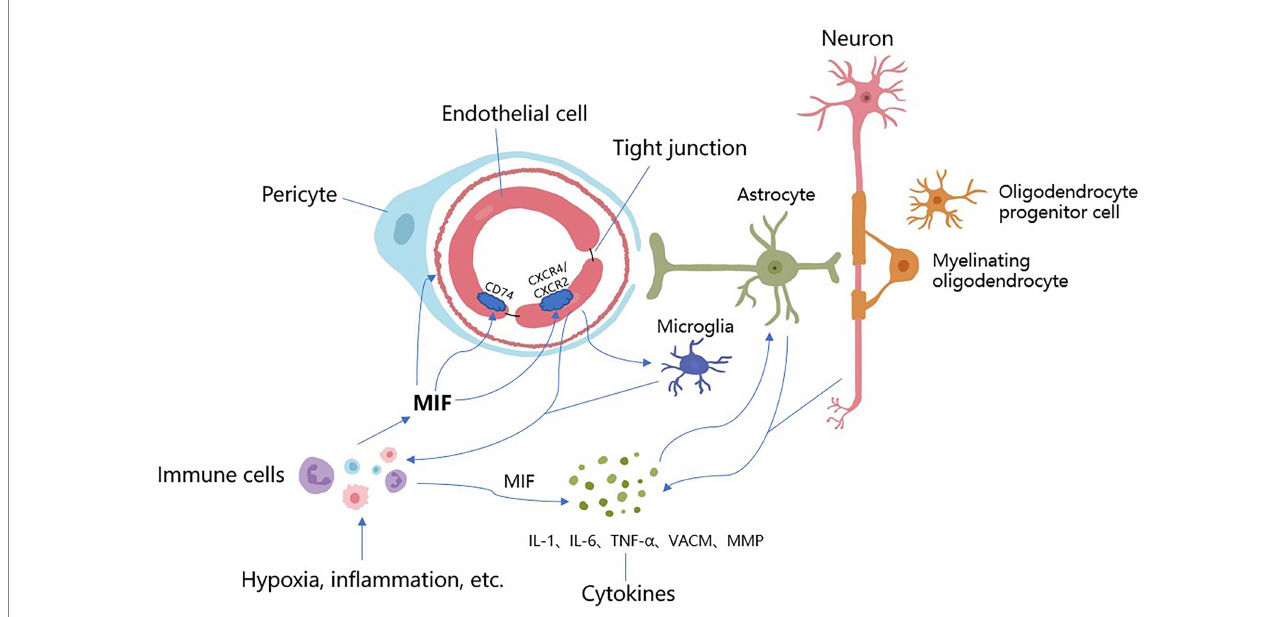
FIGURE 1 The underlying mechanisms of MIF acting on CSVD. Stimulated by hypoxia, inflammation and other factors, MIF is expressed in large quantities from immune cells (i.e., mononuclear, macrophages), which promotes arteriolosclerosis, narrows the lumen and reduces cerebral blood flow, resulting in further hypoxia and ischemia of the brain parenchyma. After binding to receptors, MIF causes endothelial autophagy, promotes endothelial cell dysfunction and BBB destruction, increases vascular permeability, allows harmful components and immune cells to enter the brain parenchyma, and causes neuroinflammation and direct neurotoxic effects. Meanwhile, MIF activates immune cells and microglia, promotes the expression of MIF, activates a series of cytokines (IL-1, IL-6, TNF- α , VCAM, MMP, etc.), accelerates inflammatory response, induces vascular damage, and destroys the integrity of the blood– brain barrier and white matter. These inflammatory factors directly stimulate astrocytes and neurons to produce more cytokines, promoting further BBB damage and inflammation. There are overlapping reactions between various